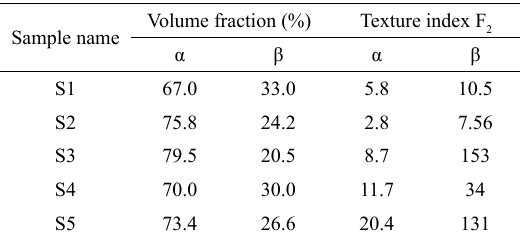
Table 2. The volume fraction and the texture index of each phase in different